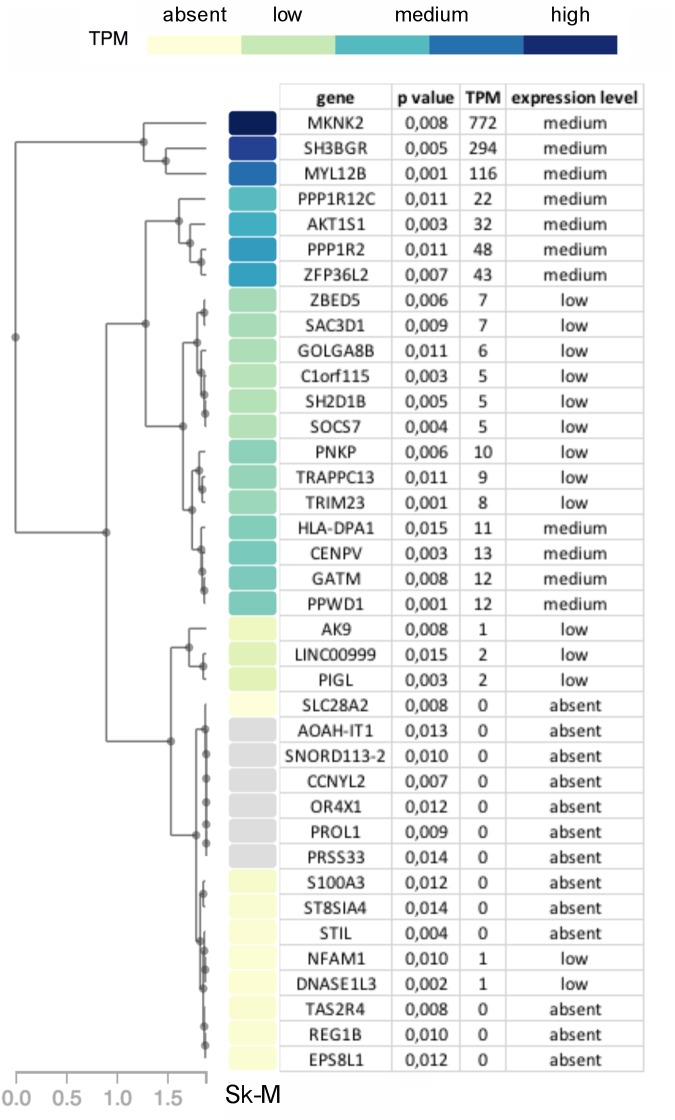
Diagram showing genes with p-value < 0.015 in OP-MG vs. control MG gene based association analysis with a heat map of their respective transcripts per million (TPM) expression value based on skeletal muscle tissue RNAseq expression data (Sk-M) from the Genotype-Tissue Expression (GTEx) project.